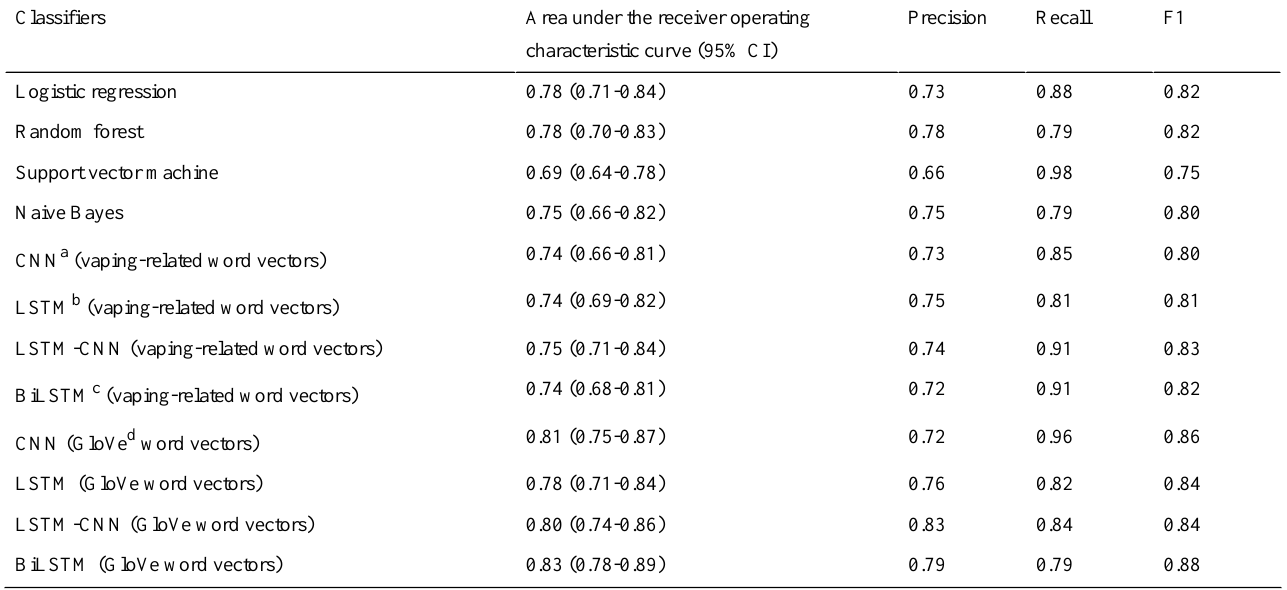
Table 8. Performance of sentiment